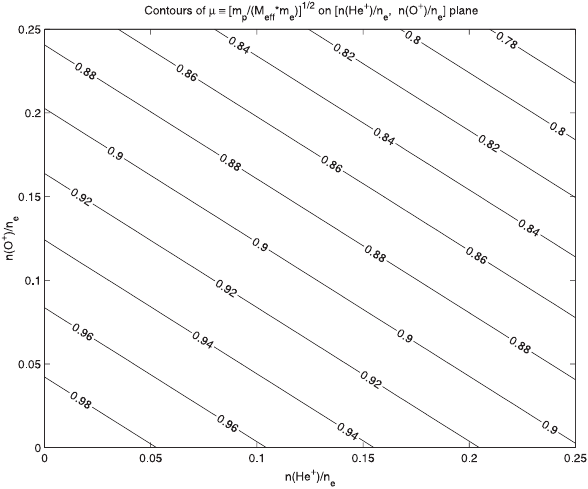
Fig. 13. LHR frequency for various ion composition and finite val- ues of ω H /ω p